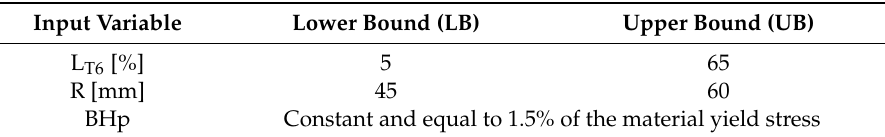
Table 2. Definition of the input variables and their variation